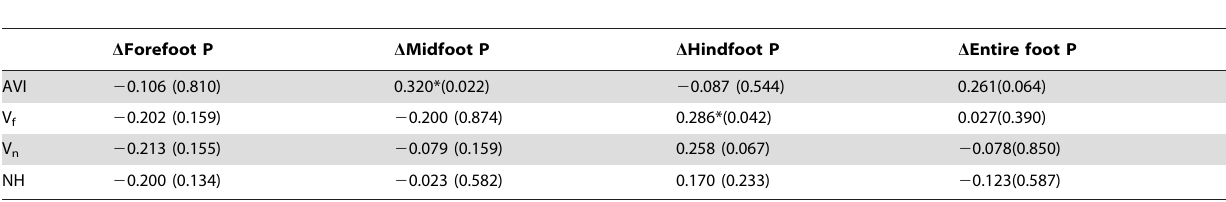
Table 3. The correlation between foot arch parameters and the change in foot pressure during the foot flat phase.